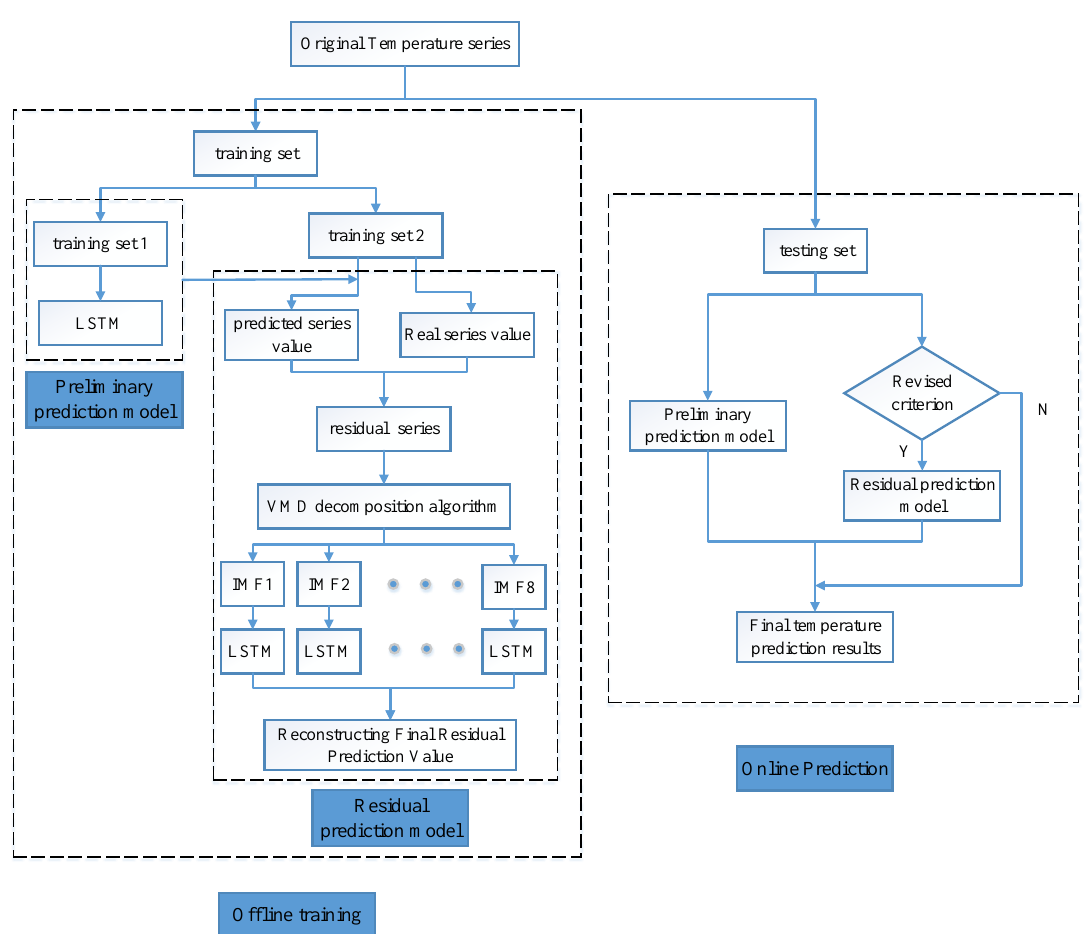
Figure 1. The overall framework of the proposed model.